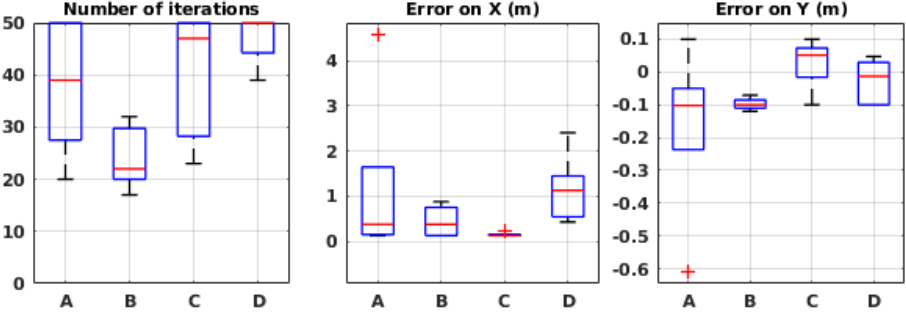
Figure 10. Evaluation results in wind tunnel experiments in different environmental conditions. Refer to Table 1 for the meaning of the